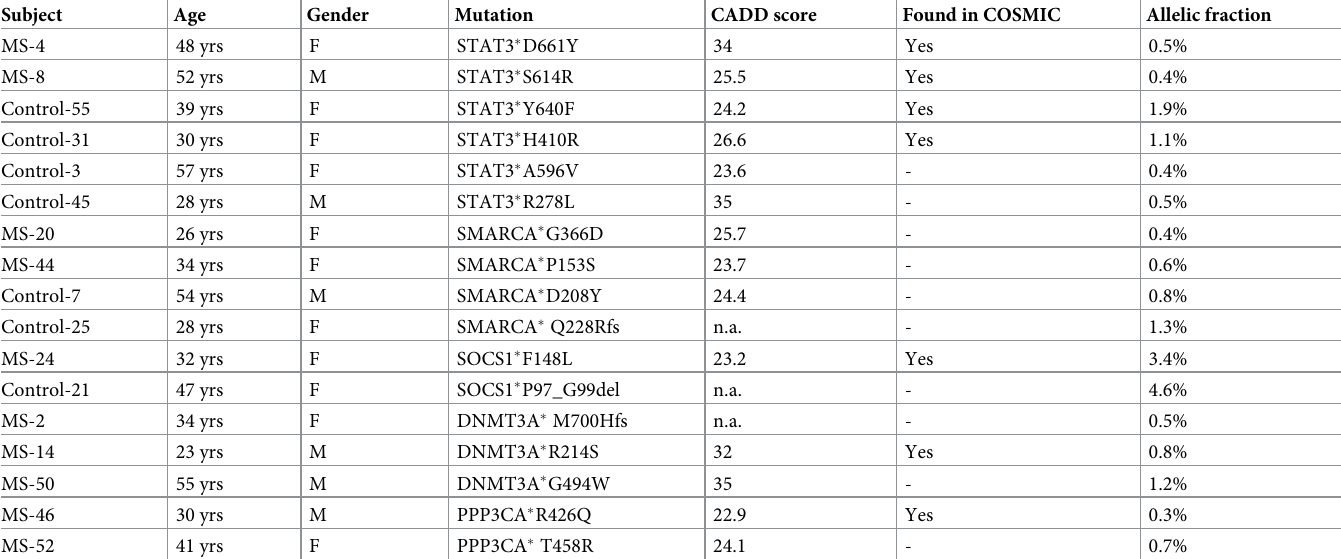
Table 4. Top 5 mutated